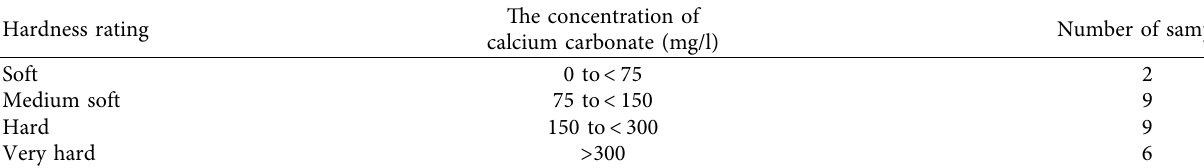
Table 1: Hardness classifcation of water [48].